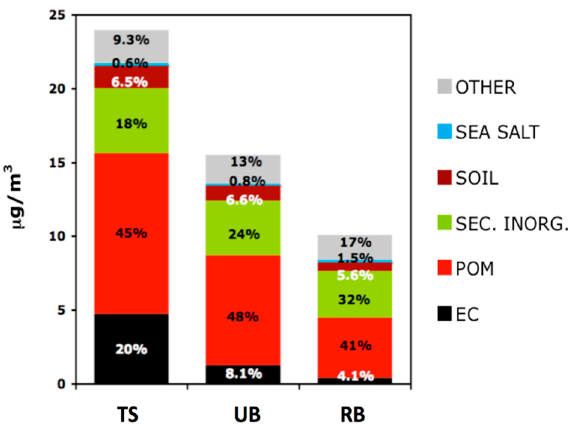
Figure 2. Annual averages of PM 2.5 main components in the TS, UB and RB sampling sites.